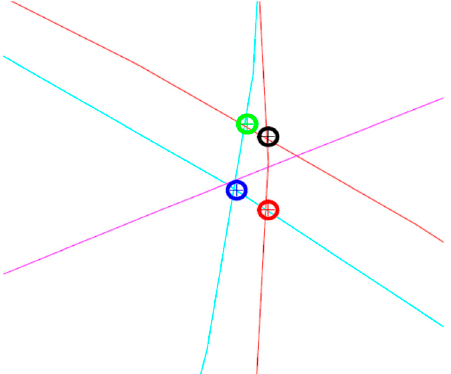
(14) Selection of real roots of the equation and elimination of multiple roots x (cid:1861)(cid:1858)_(cid:1861)(cid:1865)(cid:1853)(cid:1859)((cid:1876)_(cid:1871)(cid:1873)(cid:1870)((cid:1861))) = 0 (cid:1876) (cid:3046)(cid:3048)(cid:3045) (cid:3293)(cid:3280)(cid:3276)(cid:3287) = (cid:1876) (cid:3046)(cid:3048)(cid:3045)((cid:3036)) (cid:1876) (cid:3046)(cid:3048)(cid:3045) (cid:3293)(cid:3280)(cid:3276)(cid:3287)(cid:3296)(cid:3289) = (cid:1873)(cid:1866)(cid:1861)(cid:1869)(cid:1873)(cid:1857)(cid:3435)(cid:1876) (cid:3046)(cid:3048)(cid:3045) (cid:3293)(cid:3280)(cid:3276)(cid:3287) (cid:3439) (cid:1876)_(cid:1870)(cid:1873) = (cid:1876)_(cid:1871)(cid:1873)(cid:1870)_(cid:1870)(cid:1857)(cid:1853)(cid:1864)_(cid:1873)(cid:1866) . (15) In the examined cases of calculation in each individual case (after elimination of imaginary and multiple), two real intersections remained. The position of lines No. 3, 4, 5, and 6 at the time of observation ( τ = 100) is shown in Figure 9. Creating an Optimal Line n pairs of (cid:4670)(cid:1876) (cid:3036) , (cid:1877) (cid:3036) (cid:4671) , ((cid:1861) = 1,2, . . . (cid:1866)) , values of equal accuracy (weight) ((cid:1866) (cid:3408) 2) , which should satisfy the equation (cid:1877) = (cid:1853) ∗ (cid:1876) + (cid:1854) of the alignment line [28,29] were measured. The substitution of (cid:1853) ∗ (cid:1876) + (cid:1854) − (cid:1877) = (cid:1874) (cid:3036)